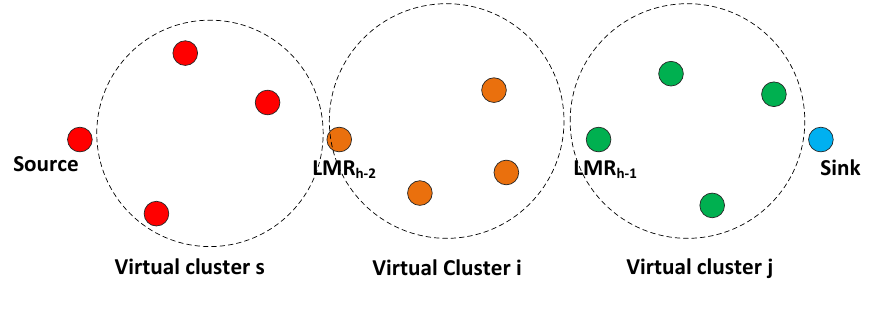
Figure 5. VCG organization after the VCG formation stage. VCG, virtual contention group; PU, primary